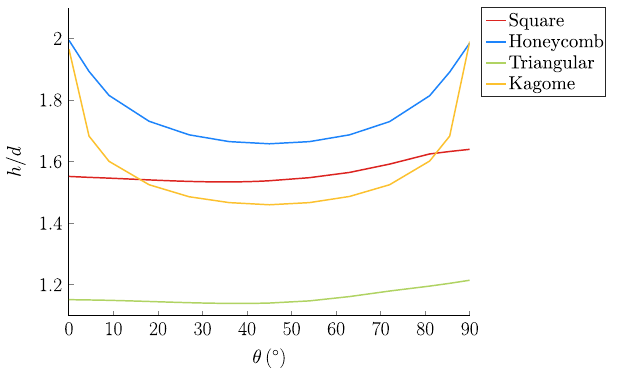
FIG. 5. The value of h=d for which a dimensionless curvature κ = ˆ κ ¼ 10 − 4 is achieved as a function of the angle of tilt of the trapping axis with respect to the normal of the plane, for several lattice geometries. For the hexagonal and kagome lattices, a strong effect is